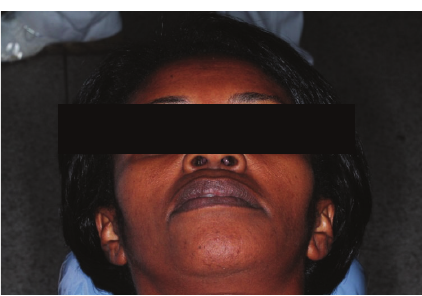
Figure 2: Panoramic radiograph indicates the left mandibular multilocular radiolucent